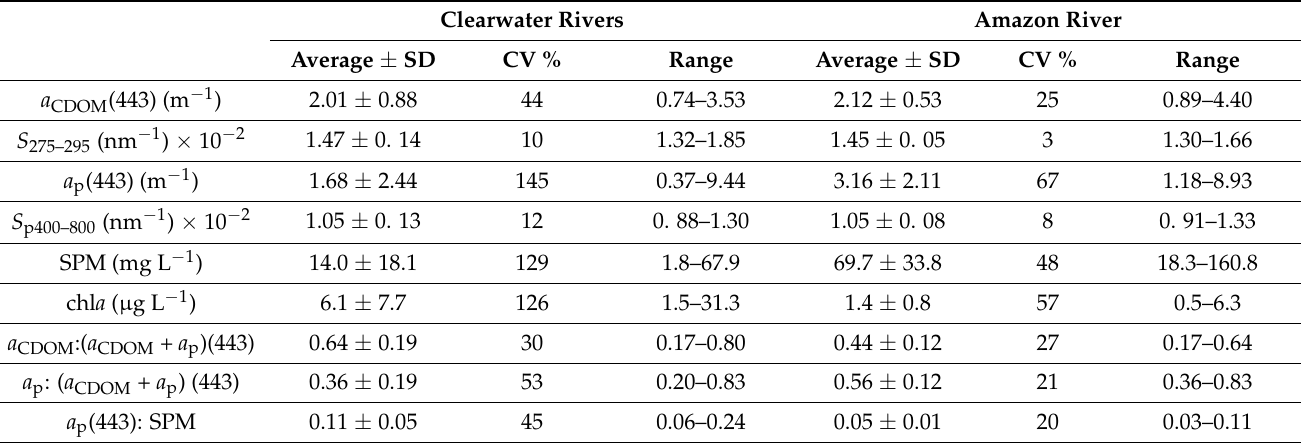
Table 2. Bio-optical characteristics of clearwater rivers and Amazon River.